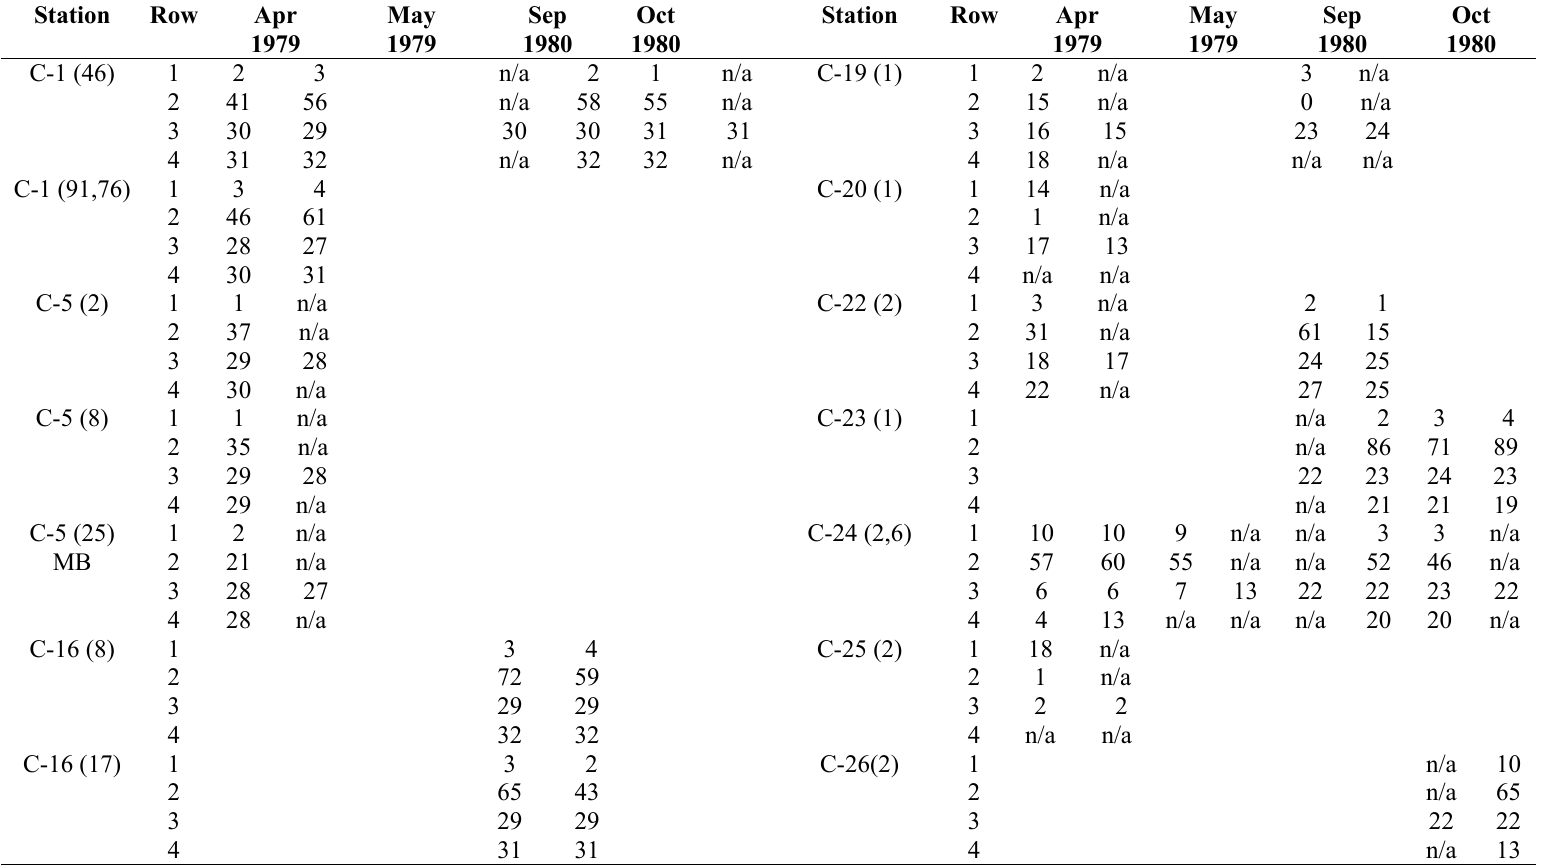
Table 11. Salinity Hindcast Validation: April 1979–October 1980. In each row box, the first column of values entry corresponds to the first 15 days of the month, with the second column denoting the remaining portion. Within each column: Row 1 corresponds to the RMSE in PSU. Row 2 corresponds to the Willmott Relative Error in percent. Row 3 corresponds to the model mean in PSU with Row 4 denoting the observed salinity mean in PSU. Note n/a denotes not available due to incomplete observations. Along with the station id, the measurement location (in distance above the bottom in meters) is given in